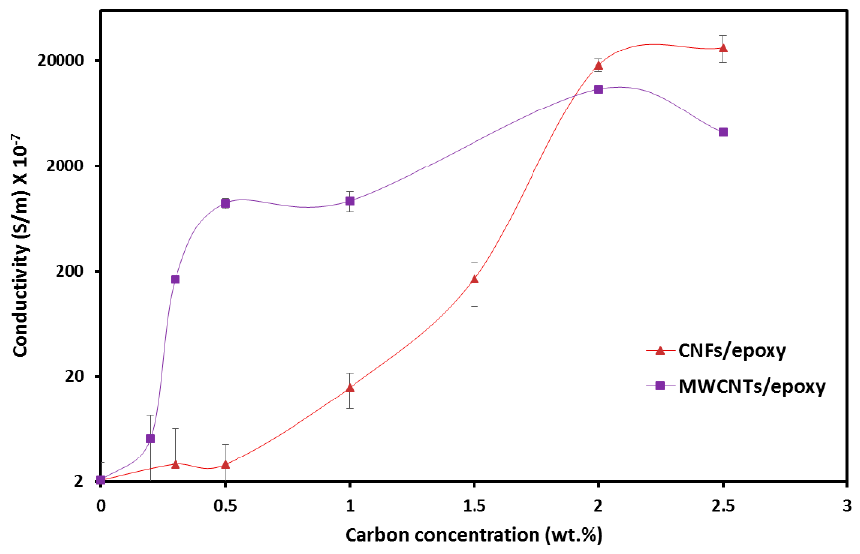
Figure 5. Electrical conductivity of MWCNTs/epoxy and CNFs/epoxy nanocomposites versus wt %.